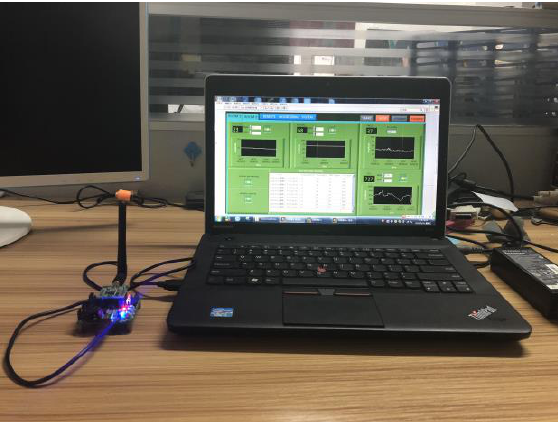
Figure 10. The remote monitoring platform.